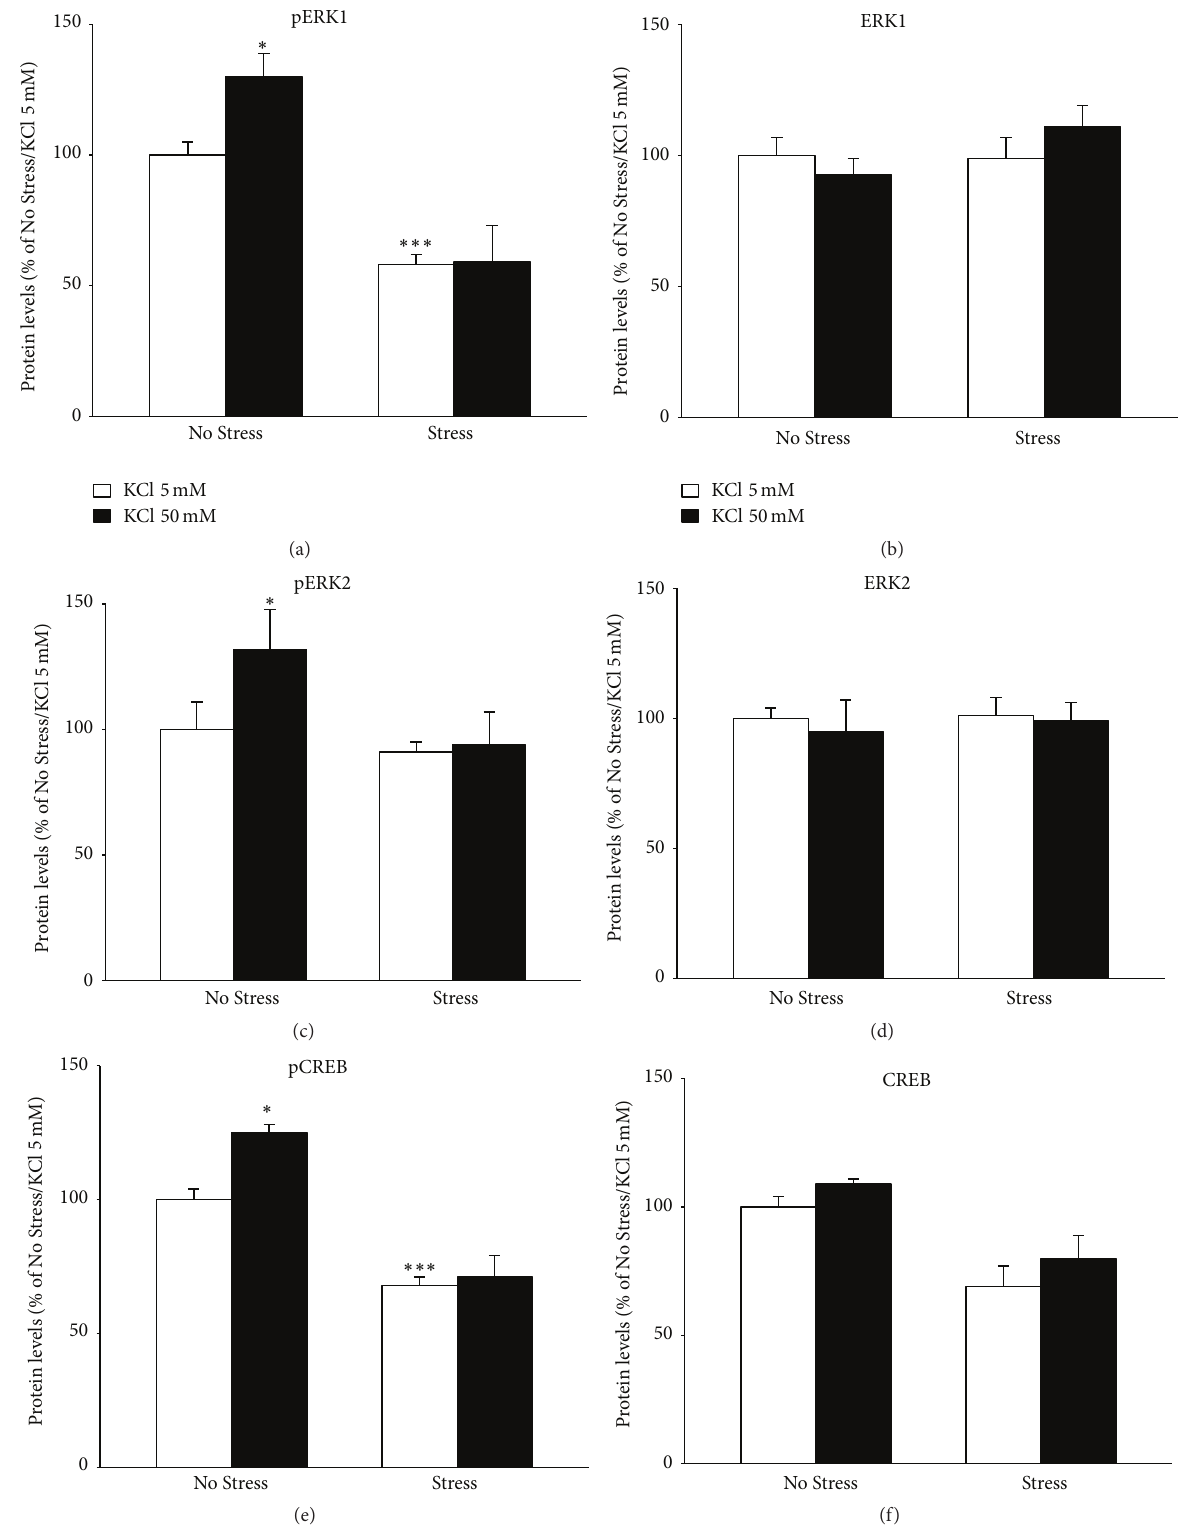
Figure 5: Protein analyses of BDNF mediated signaling: ERK1/2 kinases and CREB. The protein levels of the phosphorylated forms of ERK1 (a), ERK2 (c), and CREB (e) and their total forms (b, d, and f, resp.) were measured by Western blot analyses on protein extracts obtained from hippocampal slices obtained from unstressed (No Stress) or chronically stressed (Stress) rats exposed to KCl-induced depolarization (KCl 50 mM).Thedata,shownasapercentagereferringtocontrolgroup(NoStress/KCl5 nM),arethemean ± SEMofindependentdeterminations. ∗ 𝑃 < 0.05 , ∗∗∗ 𝑃 < 0.001 versus No Stress animals/KCl 5nM. Two-way ANOVA with